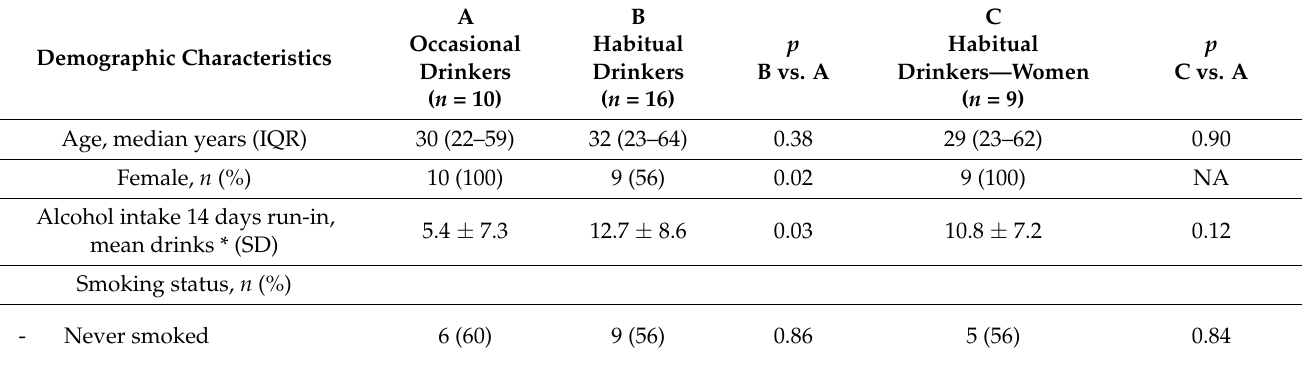
Table 2. Baseline characteristics of MetAl participants by